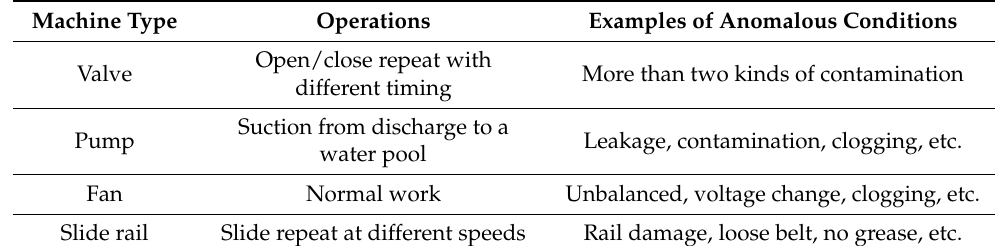
Table 8. Imbedded faults in MIMII real machines [10].